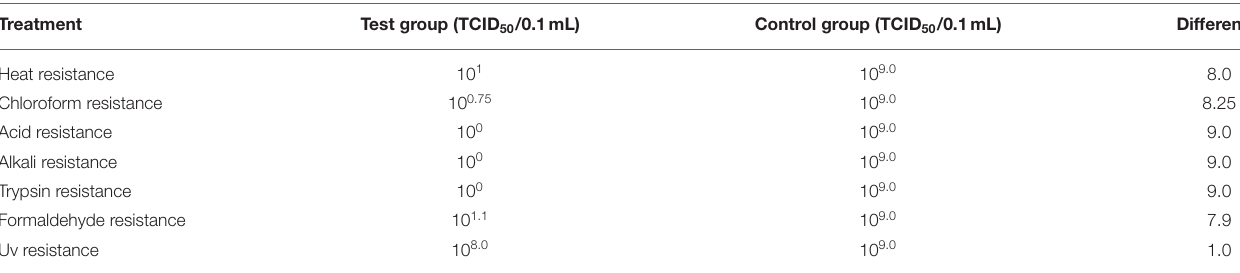
TABLE 2 | Detection results of physicochemical property tests for PRV NY isolate.